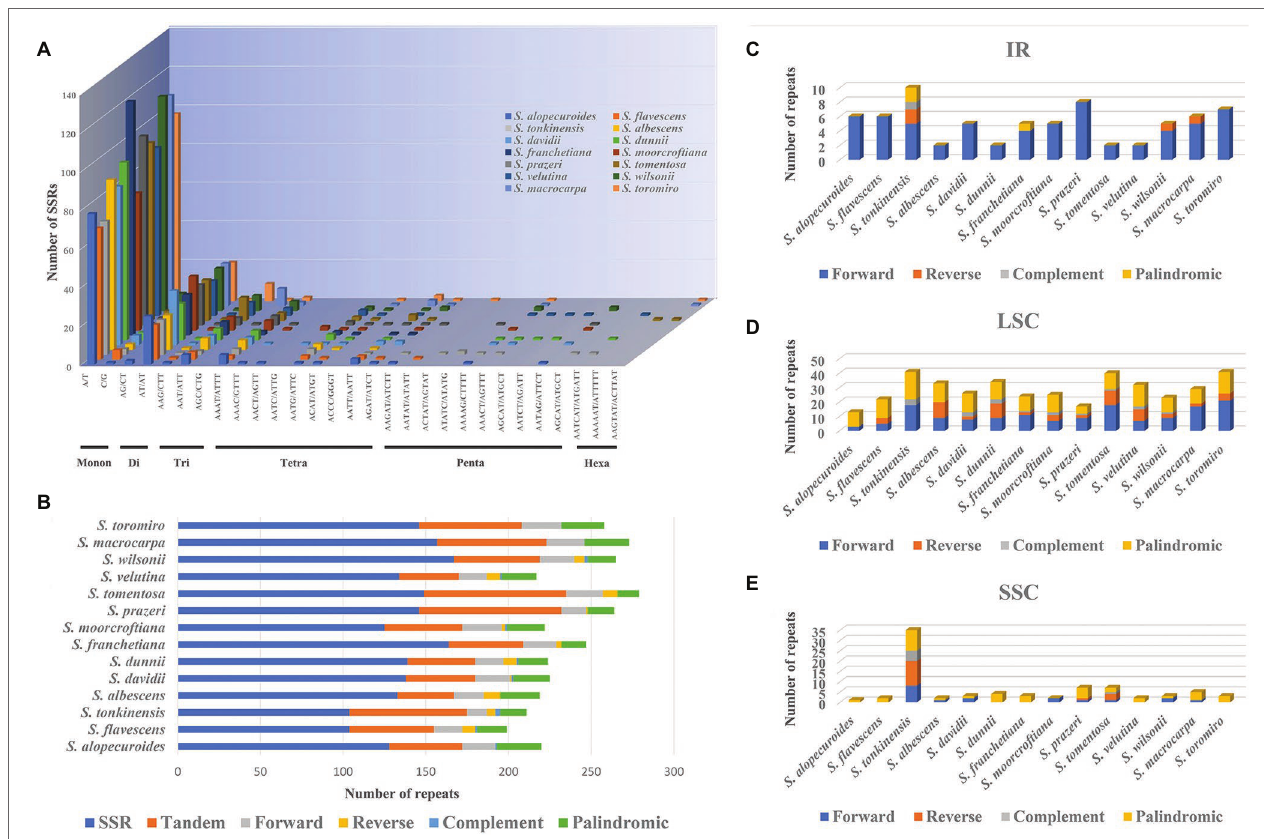
FIGURE 4 | (A) Analysis of SSRs in 14 Sophora plastid genomes species; (B) Number of SSRs, Tandem, Forward, Reverse, Complement, and Palindromic repeats in 14 Sophora plastid genomes species; (C-E) Number of Forward, Reverse, Complement, and Palindromic repeats (IR, LSC, SSC) in 14 Sophora